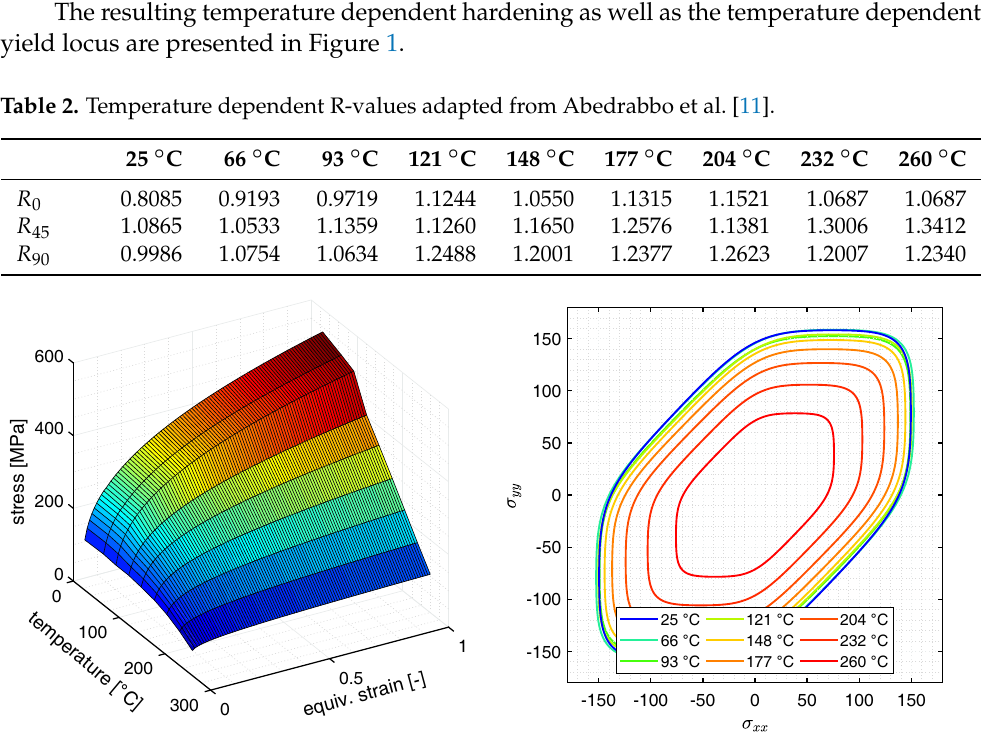
Figure 1. Temperature dependent hardening for ˙ ε = 0.01 s − 1 and the Barlat89-2D temperature dependent yield locus for material parameters adapted from Abedrabbo et al.